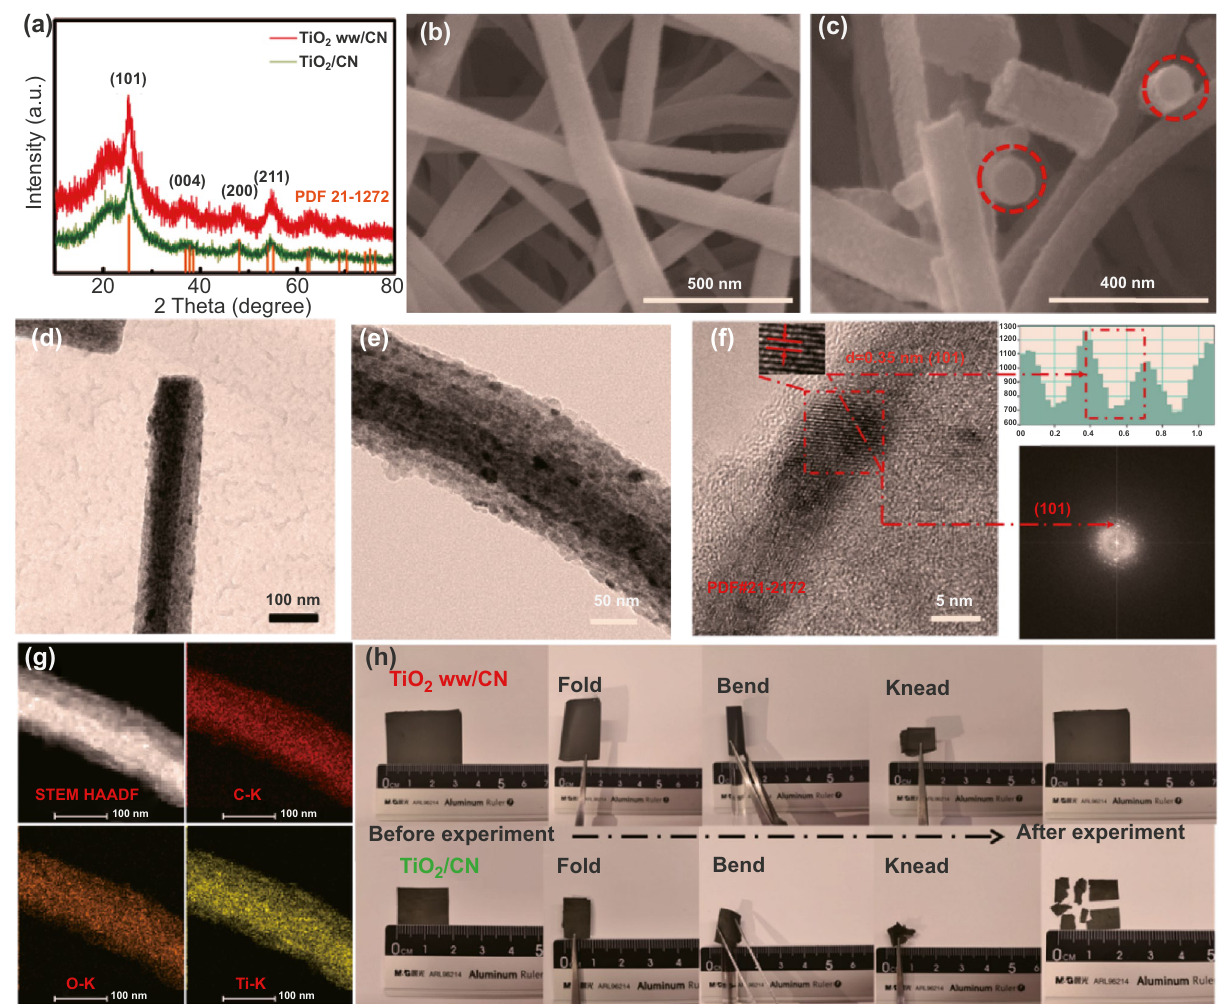
Fig. 1 a XRD patterns of TiO 2 ww/CN and TiO 2 /CN; FE-SEM images of b TiO 2 ww/CN film and c the fracture cross section nanofibers for TiO 2 ww/CN; d , e FE-TEM images, f HRTEM images, and g EDX elemental mapping images of C, O, Ti of TiO 2 ww/CN; h the digital photos of TiO 2 ww/CN film and TiO 2 /CN film before and after the experiment of completely folded, bent and kneaded in